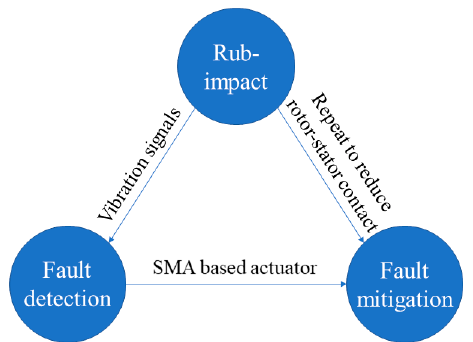
Figure 1. The basic idea of the proposed rub-impact fault mitigation method.